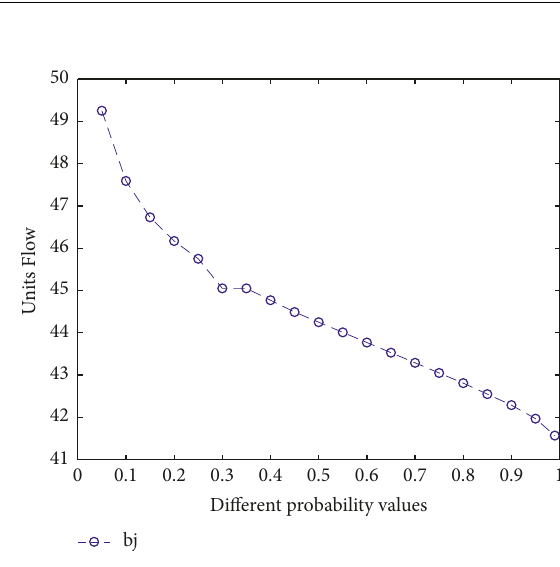
Figure 2: SA of the unit’s